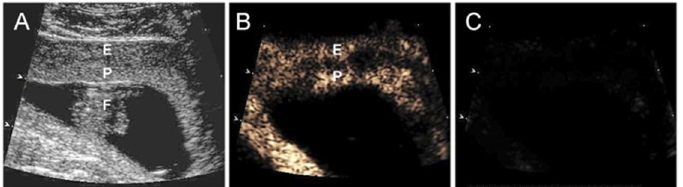
Figure 9. ( A ) Grayscale Doppler image of the endometrium (E), placenta (P), and fetus (F), and CEU images ( B ) before and ( C ) after the collapse of the MBs/uncoupling of VEGF DNA on day 45 of gestation in an E 2 -treated baboon. Reproduced with permission from [82].